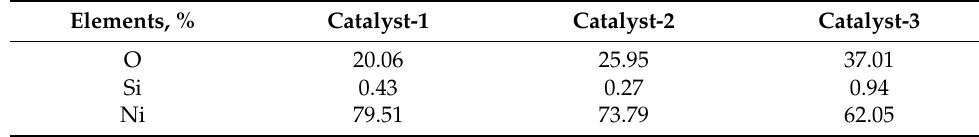
Figure 2. SEM image of catalyst - 1 ( 1 ), catalyst - 2 ( 2 ), and catalyst - 3 ( 3 ). White rectangle depicts the area of EDX data collection. Table 1. Chemical composition of nickel catalyst using EDX. Table 1. Chemical composition of nickel catalyst using EDX.